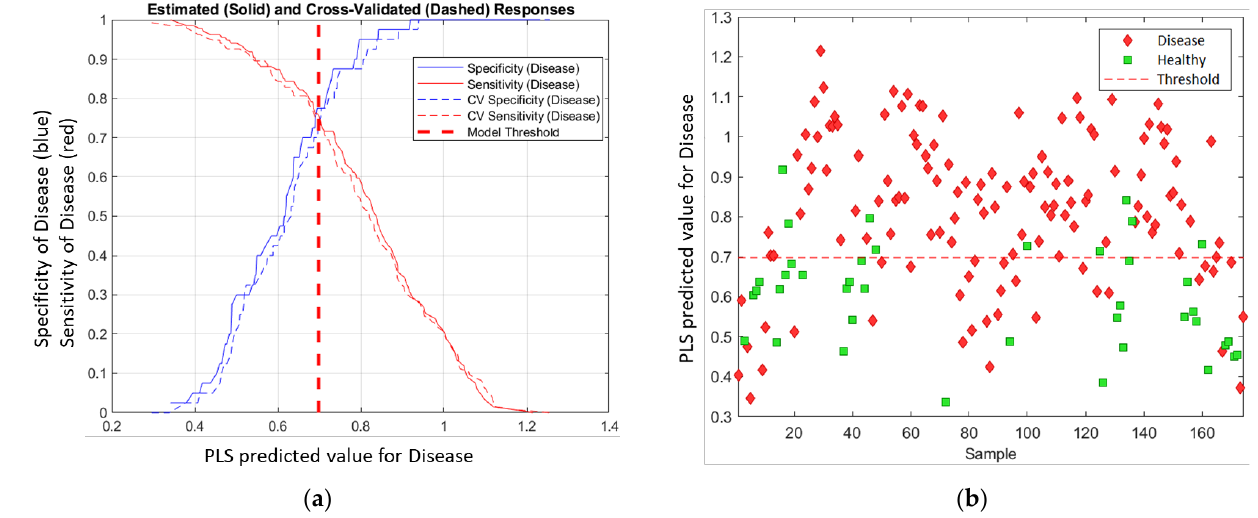
Figure 3. PLS-DA threshold determination. ( a ) ROC curve for disease class; ( b ) plot of PLS predicted value for disease class for Chardonnay in March 2021. The threshold was 0.698 in this model.